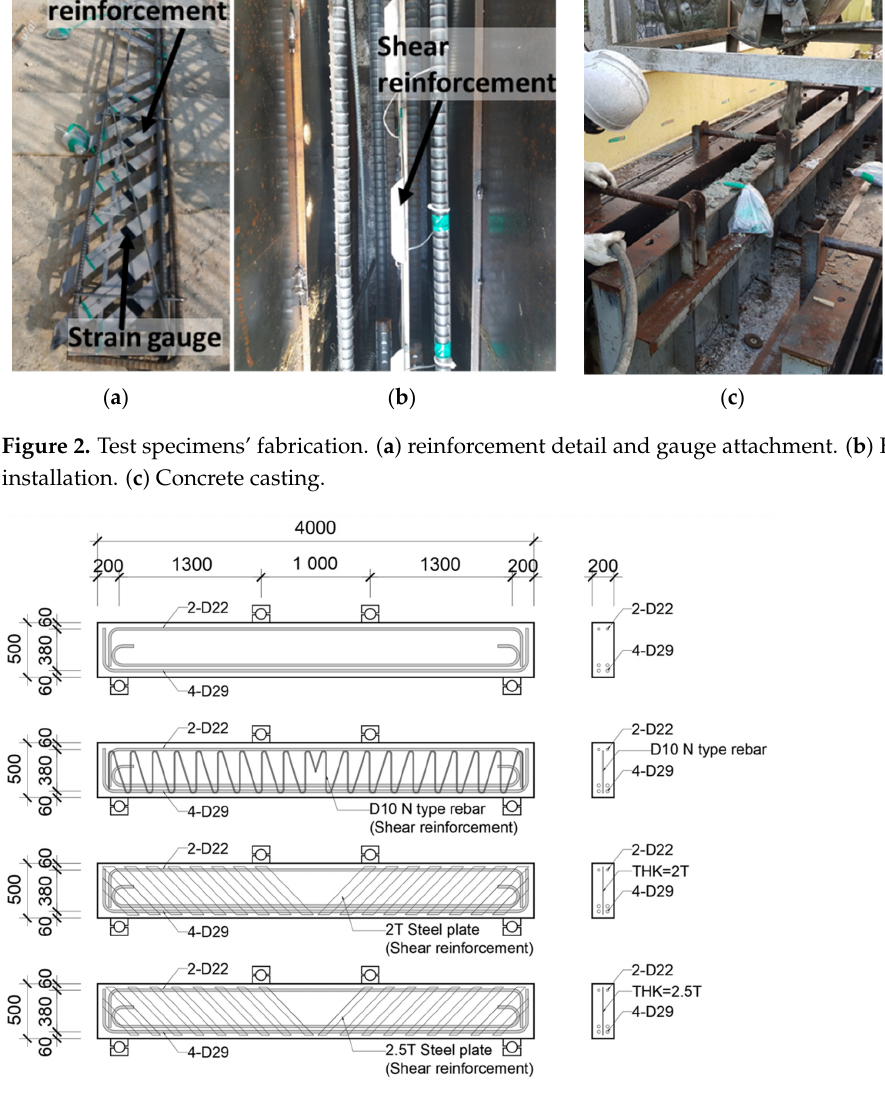
Figure 3. Test specimen details [unit: mm]. Table 1. Dimensions and material properties of the specimens.